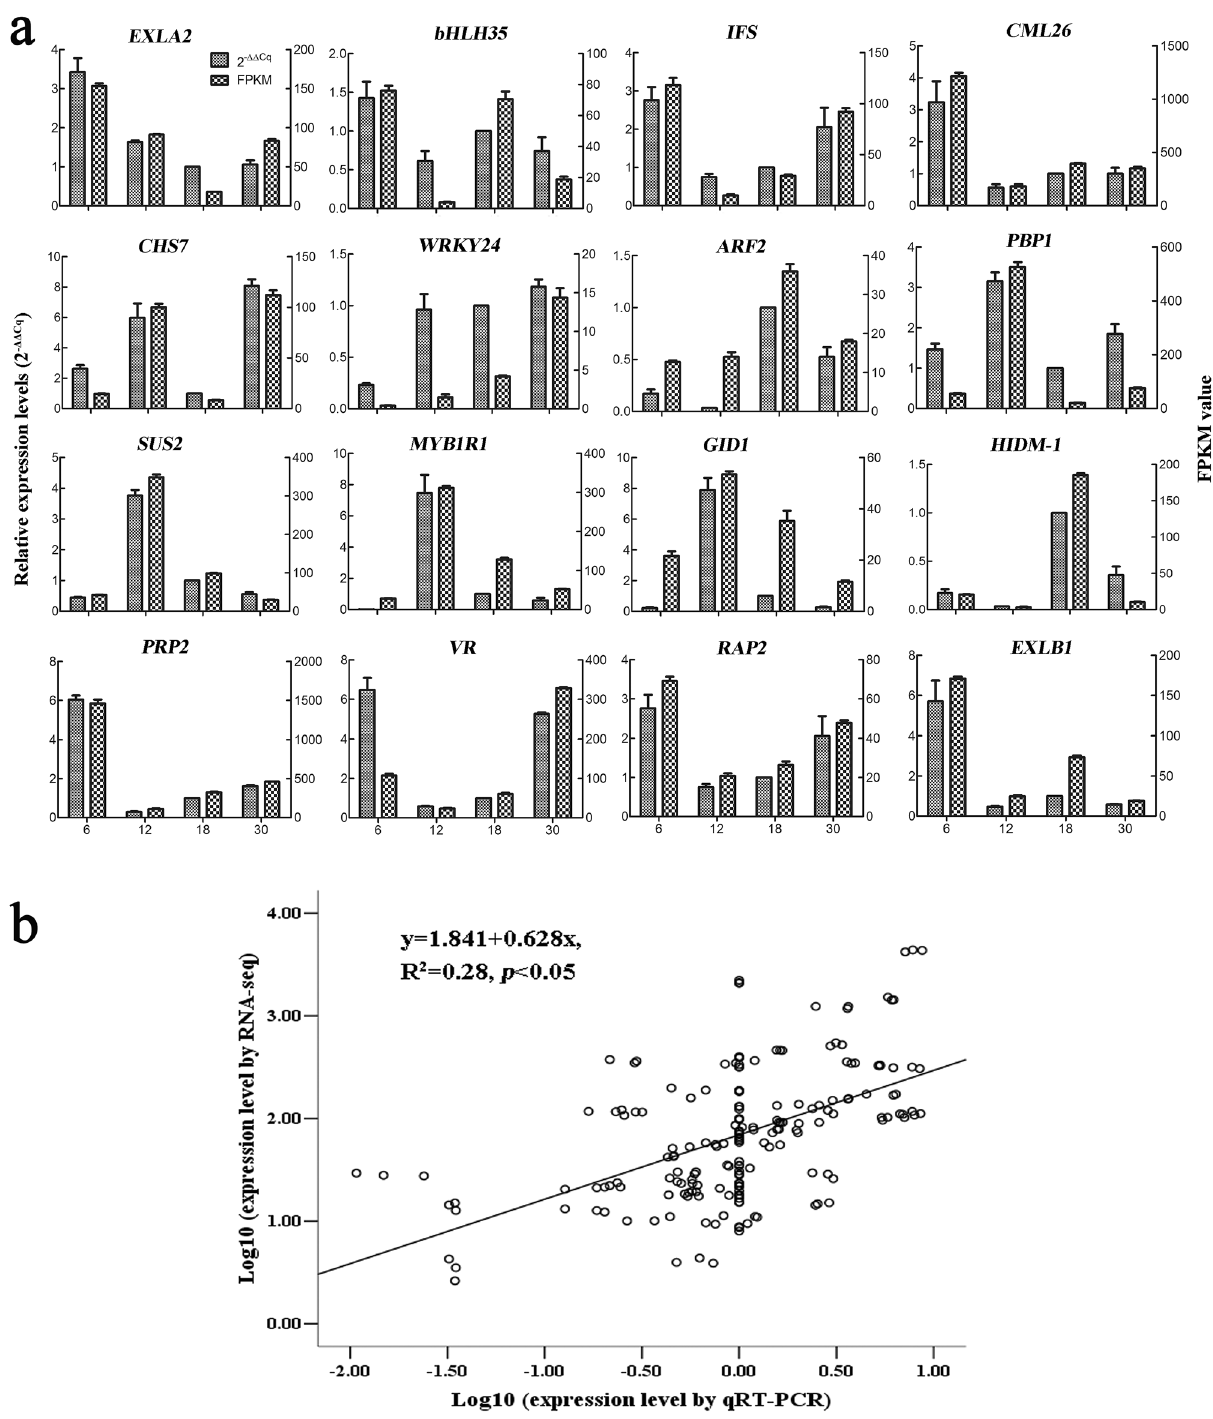
Figure 7. Validation of the transcriptomic data with qRT-PCR. ( a ) Comparison of the expression levels between qRT-PCR and FPKM values identified by transcriptome. ( b ) Correlation plot of the qRT-PCR (2 −ΔΔCq ) and FPKM values. The R 2 value represents the correlation between the qPCR and RNA-seq